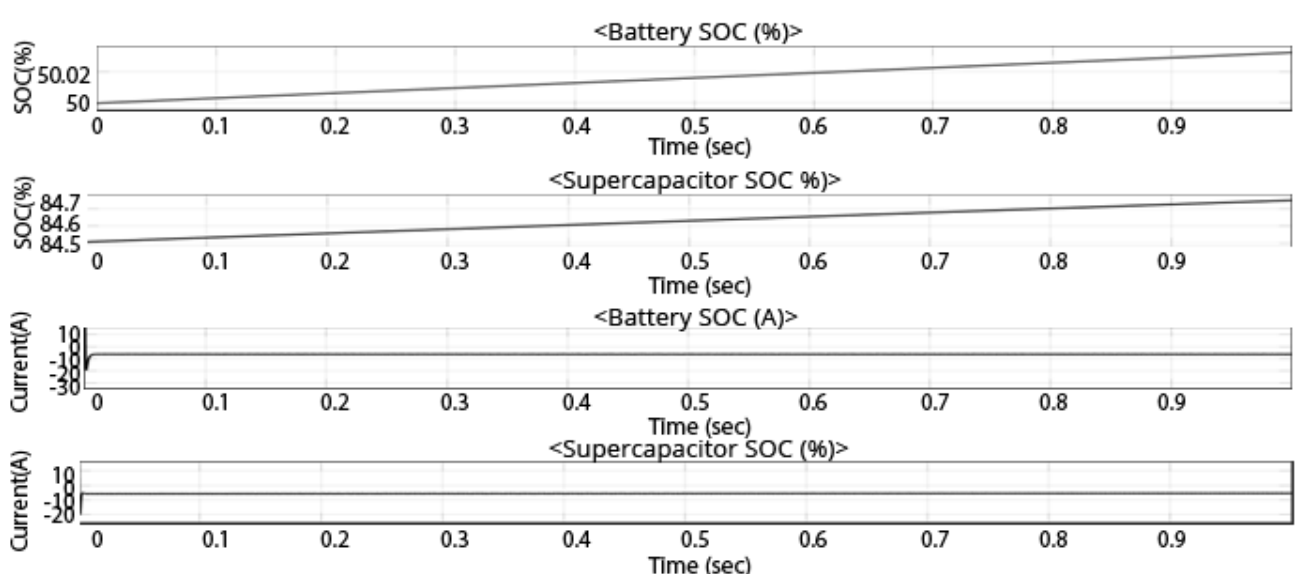
Figure 13. SOC and charging currents of battery and supercapacitor in mode 5.